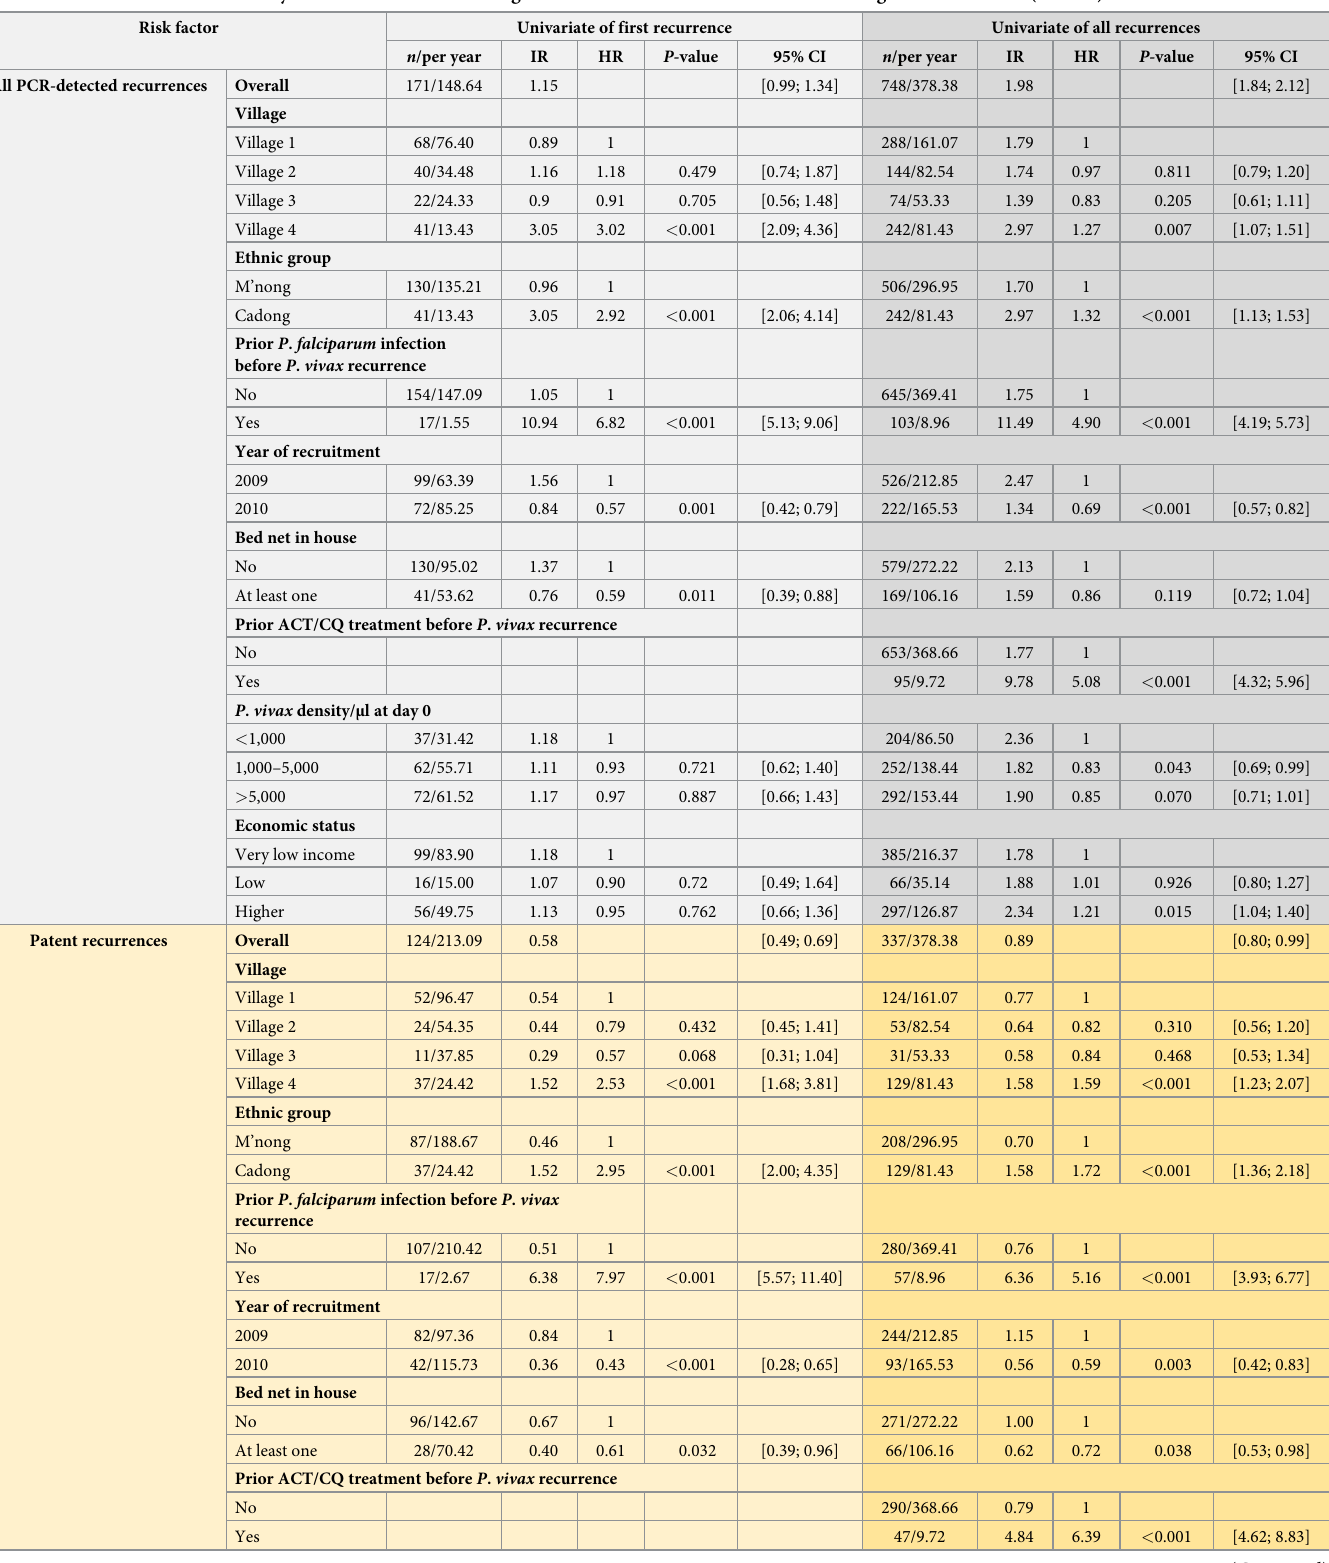
Table 3. Univariable risk factor analysis for first recurrence using Cox PH model and for all recurrences using Cox CGT model ( n = 223). Risk